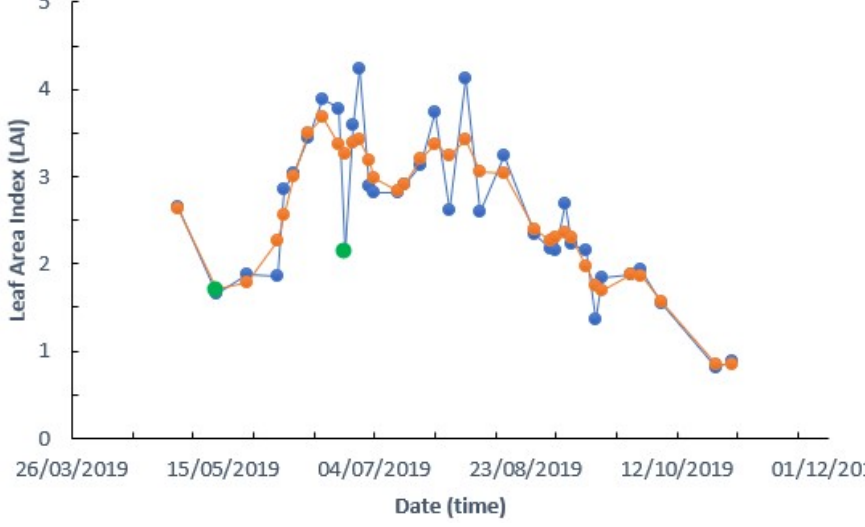
Figure 6. Observed LAI time series (blue) and smoothed LAI time series (orange) of an IPG pixel. Green dots correspond to minimum LAI detected on the smoothed LAI time series.